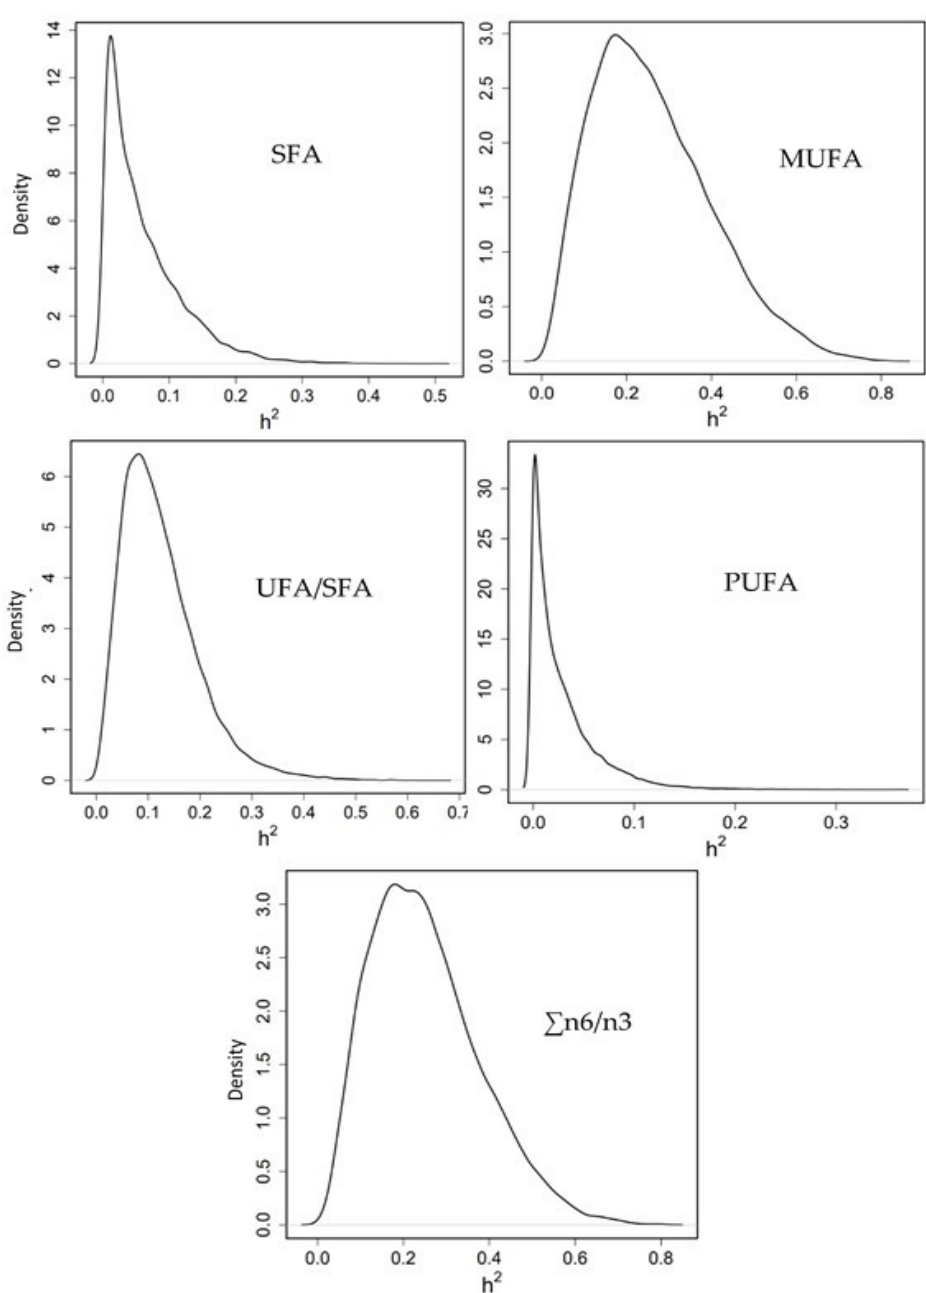
Figure 4. Posterior marginal distribution of heritabilities of SFA: saturated fatty acids, MUFA: monounsaturated fatty acids, PUFA: polyunsaturated fatty acids, UFA: unsaturated fatty acids and the ratio omega 6/omega 3 fatty acids in gilthead seabream. h2 = heritability. 399 data.